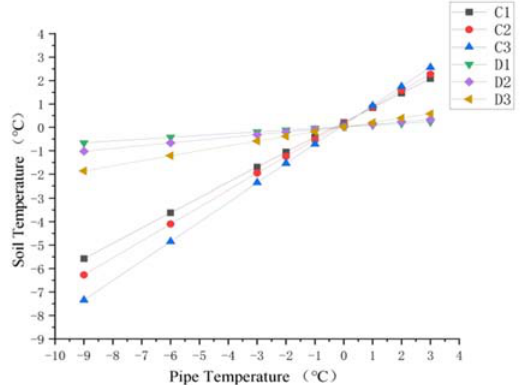
Figure 18. Diagram of soil temperature trend on the right side of the inlet ascending pipe.